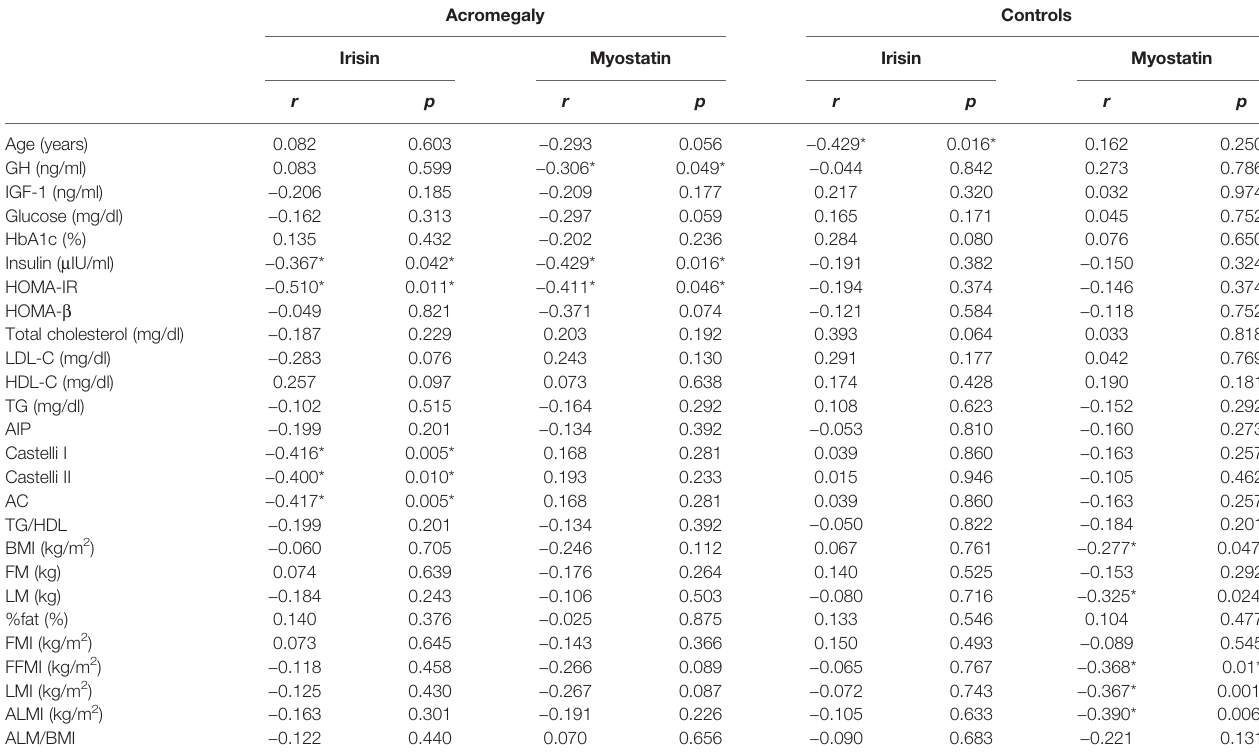
TABLE 5 | Correlations of the circulating myokine concentrations with metabolic parameters in patients with